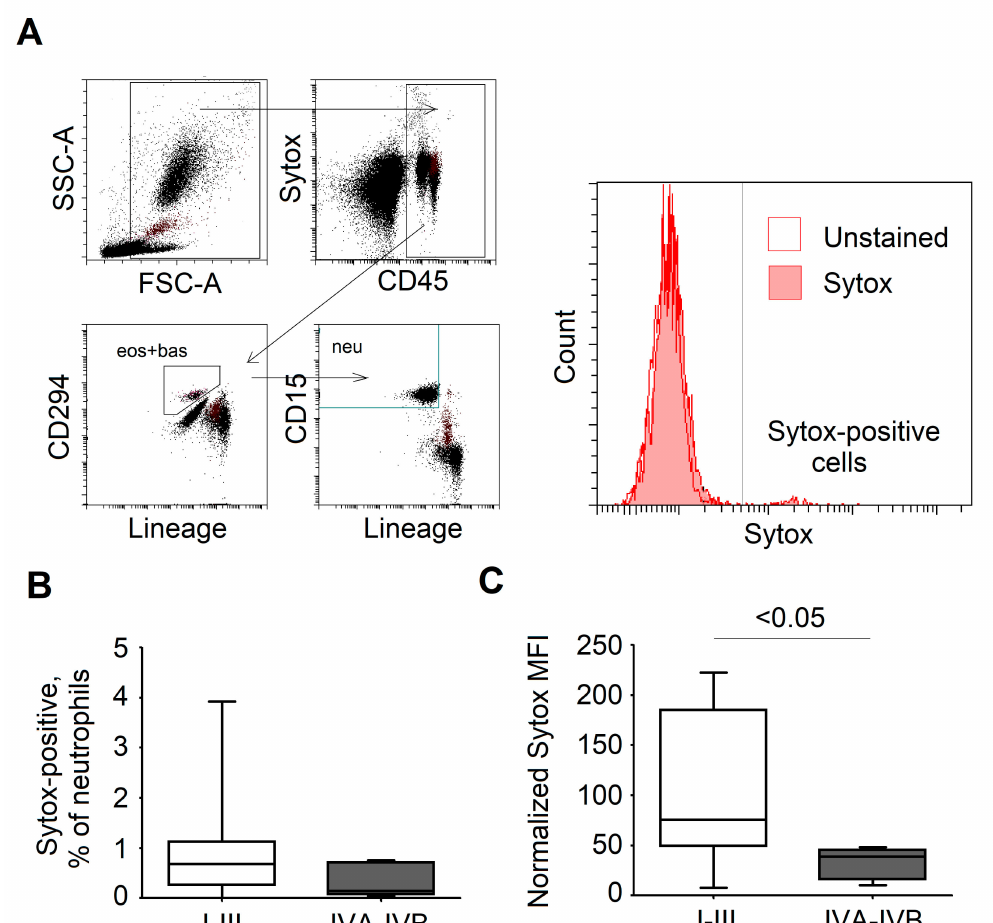
Figure 6. Elevated NET release in early stages of HNC demonstrated in flow cytometry using SYTOX staining. ( A ) Gating strategy for SYTOX expression on blood neutrophils. Neutrophils are